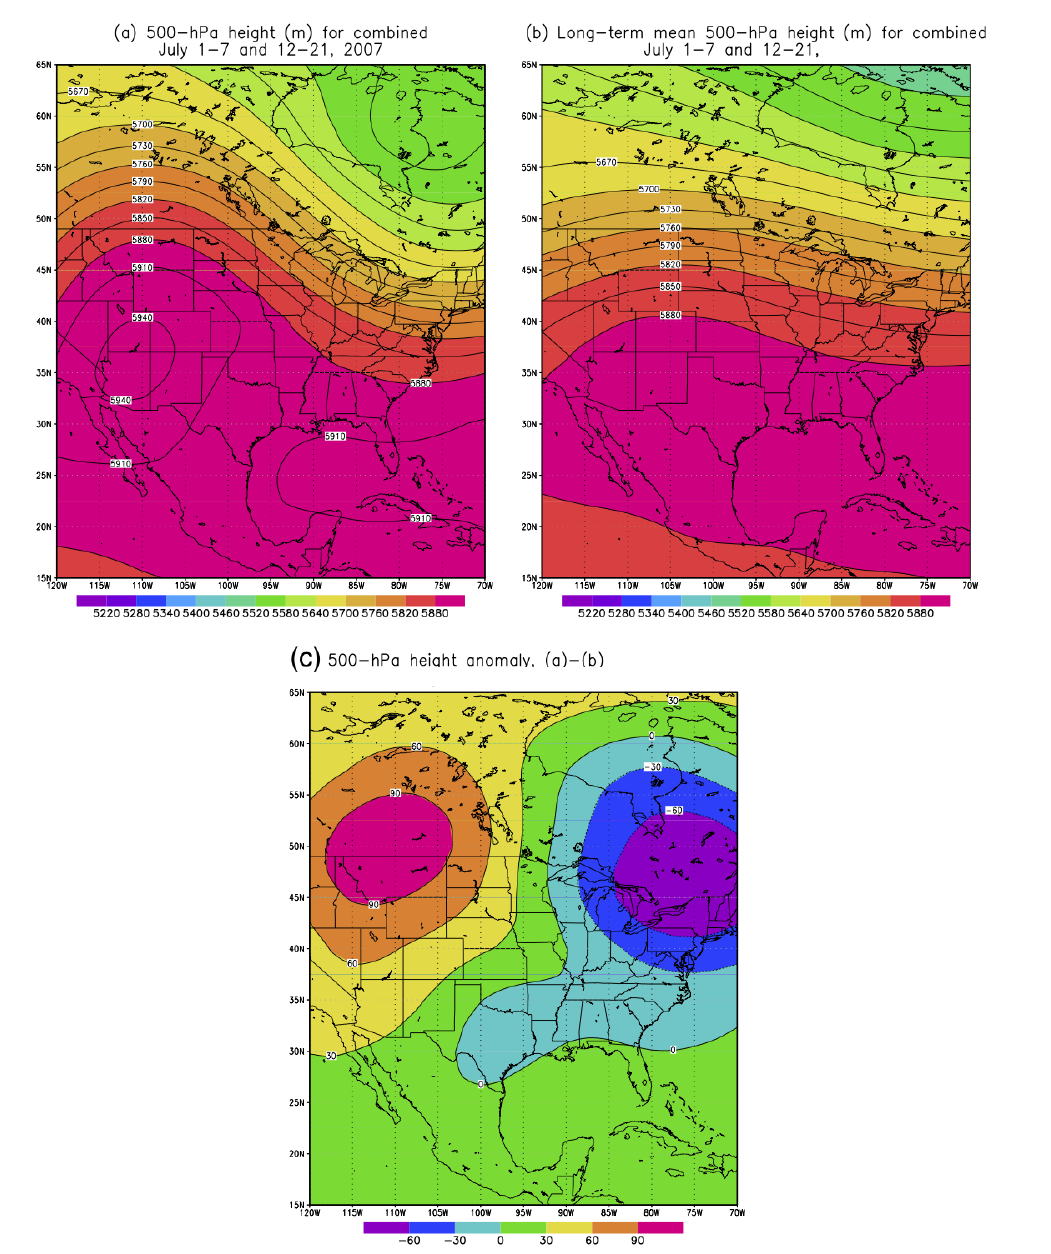
Figure 9. Same as Figure 4, except for the July 2007